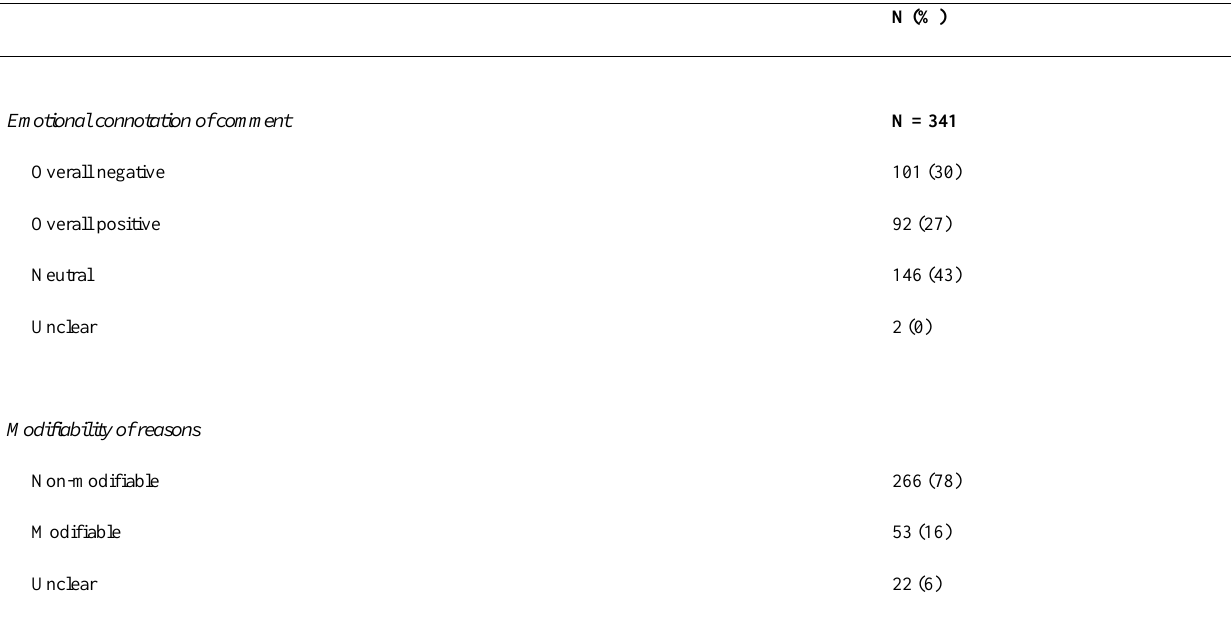
Table 1S Emotional connotation and modifiability of reasons for non-participation among 341/684 survey respondents providing specific